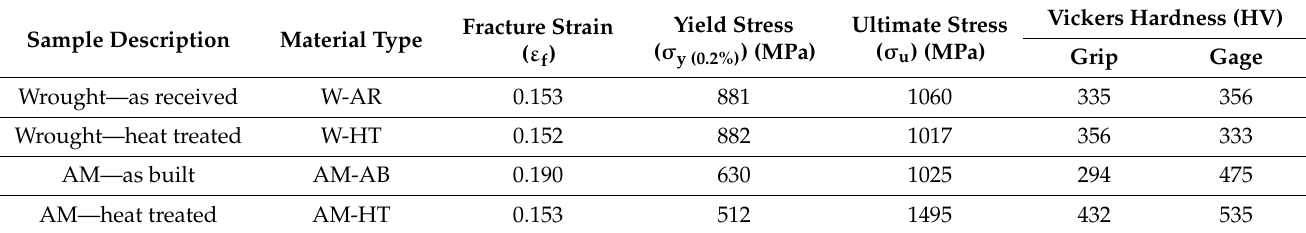
Table 2. Tension and micro-hardness material characterization